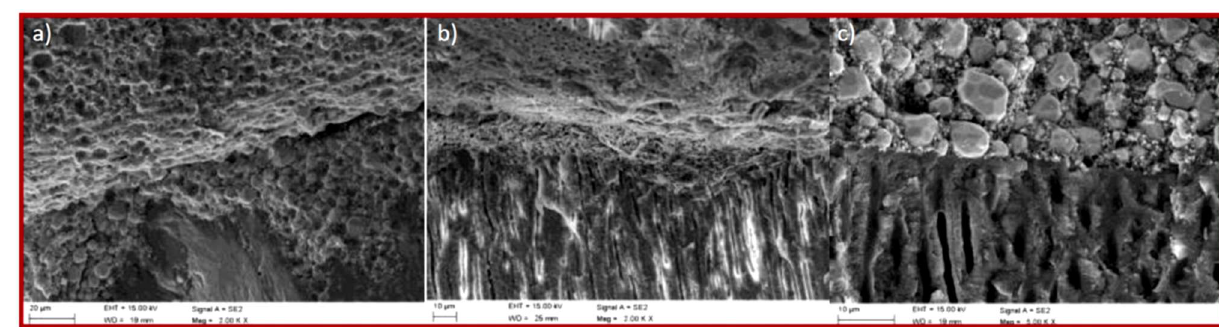
Figure 15. Scanning electron microscope view of a tooth fracture: ( a ) tight connection of three layers of filling material on a gutta-percha matrix covered with sealant, showing sealant and root dentine after filling with gutta-percha studs using the thermoplastic method (2000 × ); ( b ) tight connection of the root dentine with the filling material based on Resilon-type polymer materials, covered with a thin intermediate layer of the sealant, with a thermoplastic method visible after filling with the use of studs of the Resilon-type material and a visible cross-section of the dentinal tubules along their axis transversely to the axis of the root canal (2000 × ); ( c ) close bonding of the intermediate layer of the sealant and root canal dentin with a visible cross-section of the dentin tubules along their axis transversely to the axis of the root canal, with the method of filling and obturation as in ( a ) (5000 × ).